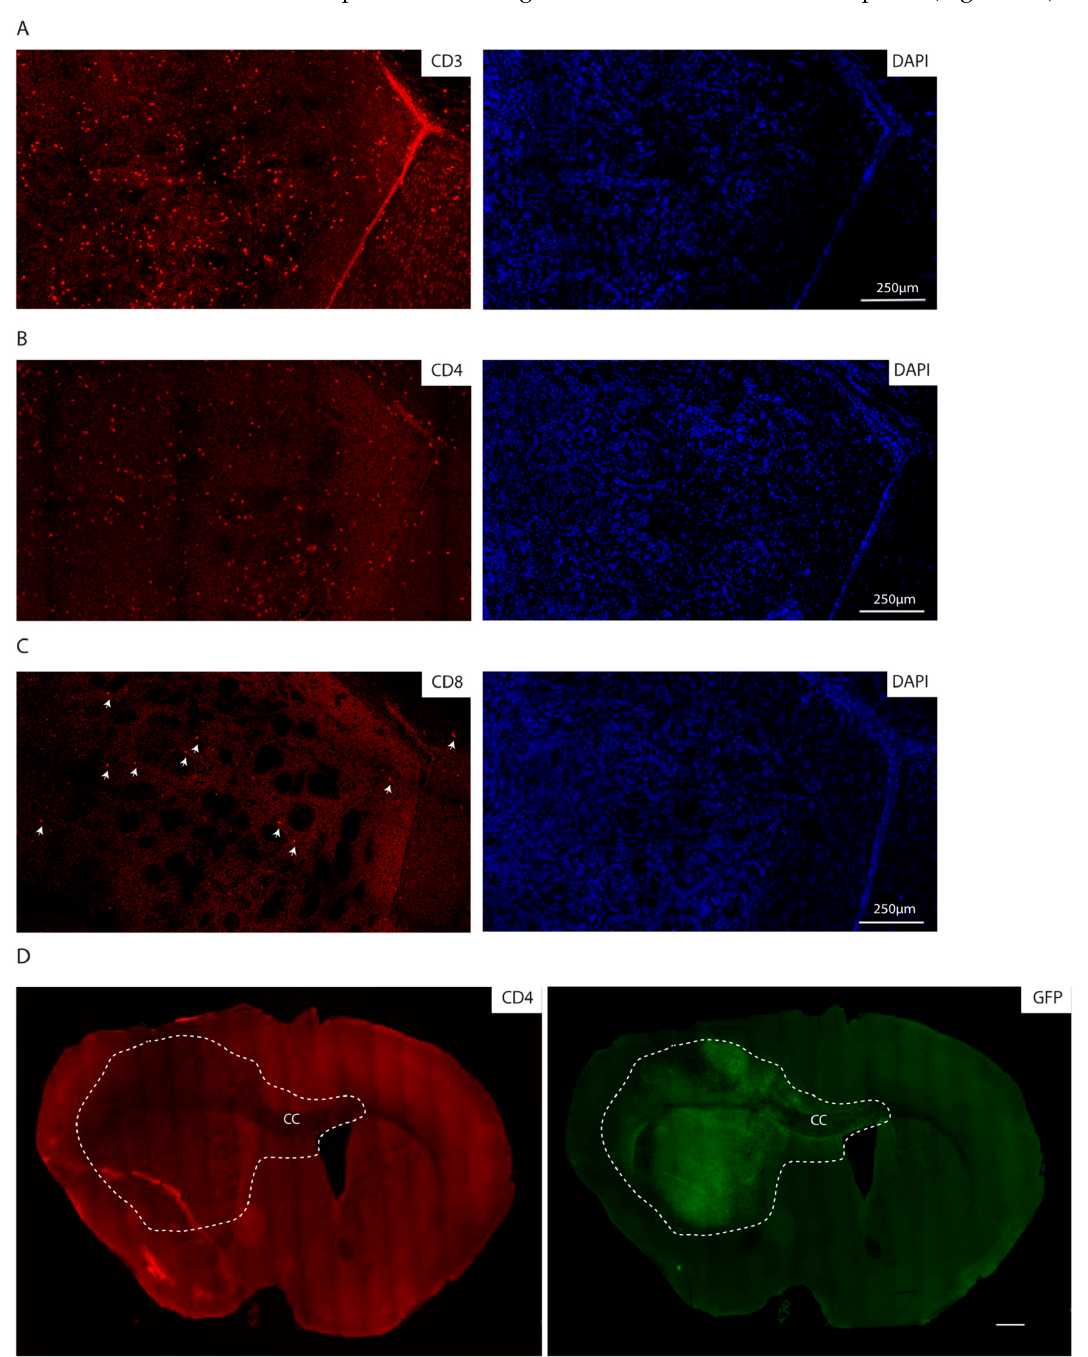
Figure 5. The syngeneic GBM show lymphocyte infiltration. ( A – C ) Immunofluorescence staining of the core of an mGB2 orthotopic tumor for CD3 ( A ), CD4 ( B ), CD8 ( C ). Cellular nuclei are stained with DAPI and pseudocolored in blue. Arrows indicate CD8 positive cells. ( D ) Immunofluorescence staining of an mGB2 orthotopic tumor (entire brain section) for CD4 (in red) and GFP (in green). Scale bar, 500 µ m. Dotted lines show tumor area. CC indicates corpus